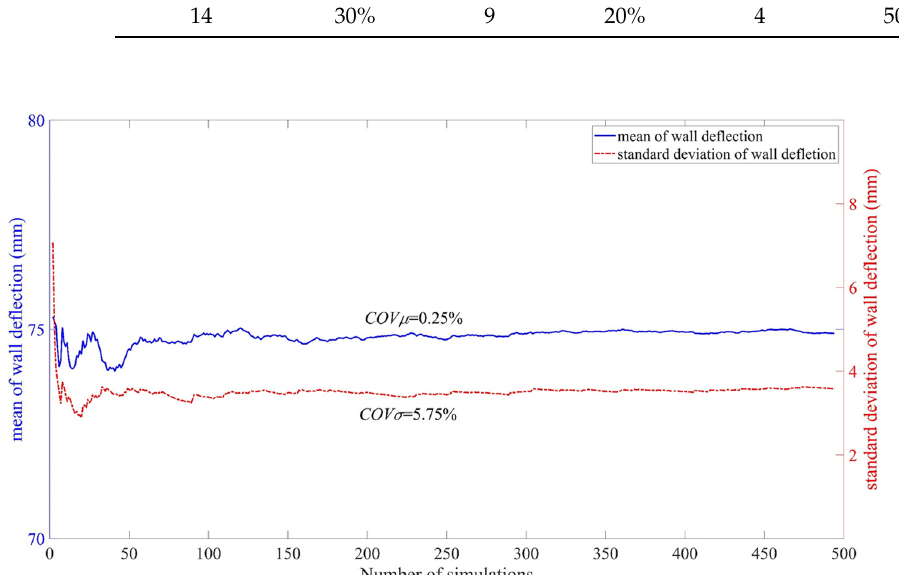
Figure 5. Convergence curve of wall deflection (case 1).